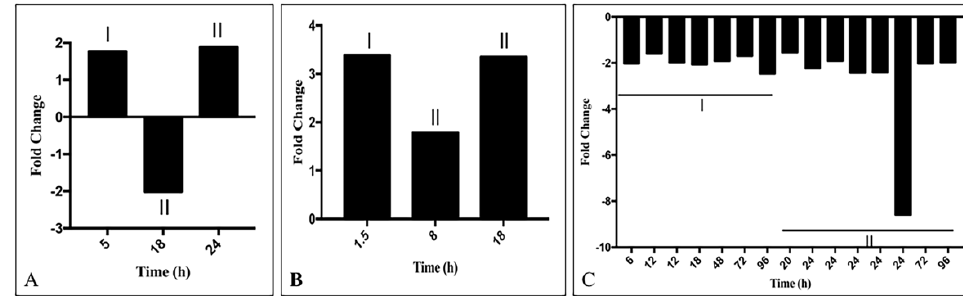
Figure 7. Representative result of changes in the expression of lncRNA NEAT1 ( A ), MALAT1 ( B ) and DANCR ( C ) at different time points by treatment with IFN-I (denoted by I) and IFN-II (denoted by II) as obtained from Interferome database (http://www.interferome.org/interferome/home.jspx, accessed on 1 July 2021).